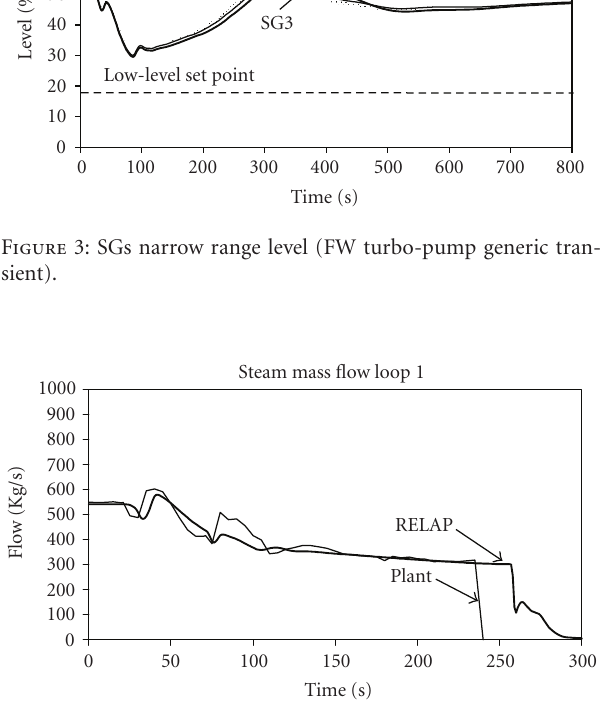
Figure 4: Steam mass flow loop1 (FW turbo-pump actual tran- sient).